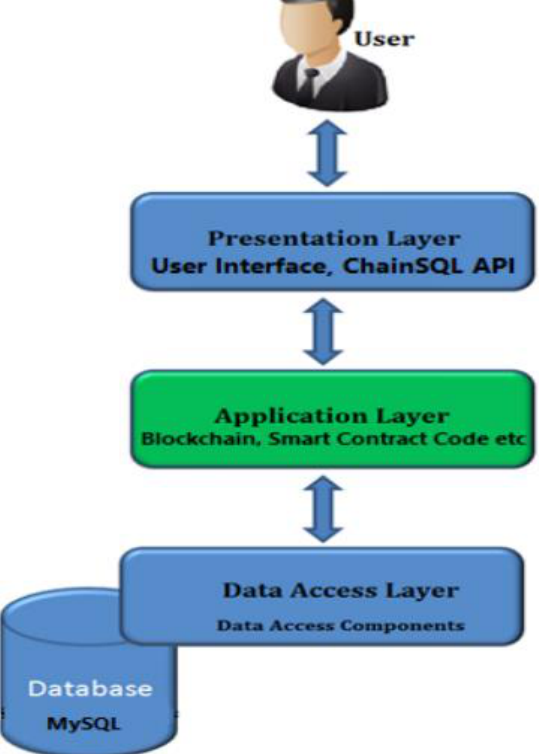
Figure 5. Three-layered architecture of the